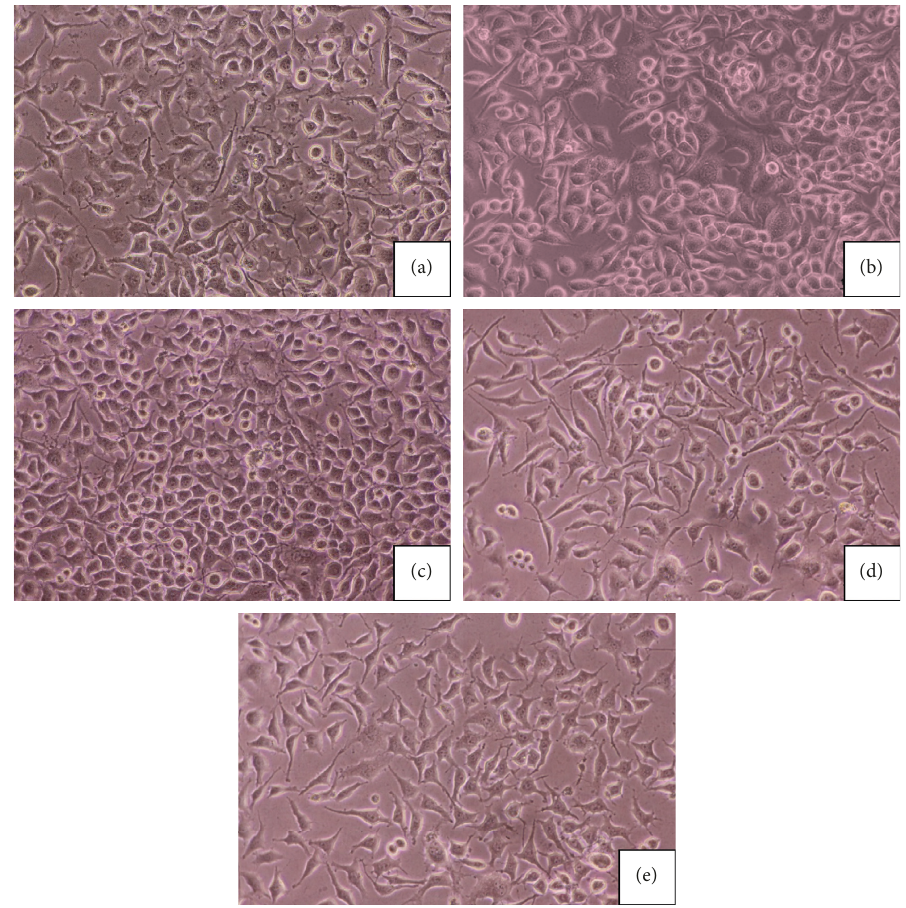
Figure 12: Indirect contact assay of AISI 316L was coated following the ISO 10993-5 standard for the MTT cytotoxicity test by using the L929cells: (a) control, (b) AISI 316L (c) pure DLC, (d) Si-DLC 1 :6, and (e) Si-N-DLC 14:1